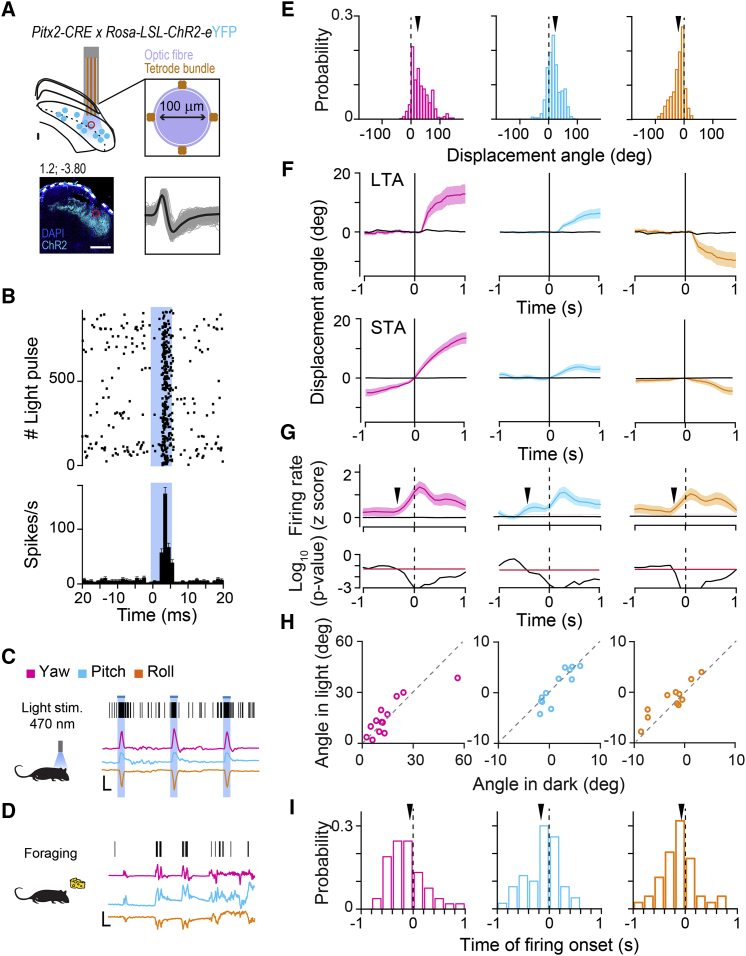
Pitx2ON Neurons Are Active Prior to Head Displacements of Fixed Metric(A) Optetrode targeted to the SGI of a Pitx2-CRE::Rosa-LSL-ChR2-eYFP mouse (top left). Optetrode design (top right): tetrode bundles (gold) around the fiber optic core (blue). Immunohistochemistry showing successful targeting of the optetrode to the SGI (bottom left, scale bar: 500 μm). Spike-sorted waveforms of a responding unit expressing ChR2 (bottom right).(B) Raster plot (top) and PSTH (bottom) for the single unit in (A) during multiple trials of blue-light stimulation (5 ms, shaded area).(C) Example of spiking activity from an optotagged unit during blue-light stimulation during open-field explorative behavior, aligned to the simultaneously recorded head displacements in yaw (magenta), pitch (blue), and roll (orange) components (scale bars: 250 ms, 20 degrees).(D) Same as in (C), for the same unit recorded during foraging behavior in the absence of blue-light stimulation.(E) Distribution of yaw, pitch, and roll head movements following the spikes of an example optotagged unit. The characteristic angle for each unit was measured as the mean of these distributions (arrowhead).(F) Light-triggered (LTA, top) and spike-triggered average (STA, bottom) of head movements in the yaw, pitch, and roll components calculated for the optotagged neuron in (E). LTA and STA were tested for significance against shuffled data (black curves).(G) Average changes in firing rate for the optotagged neuron in (F) around the onset (dashed line) of head movements, calculated separately for yaw, pitch, and roll displacements. The time of firing onset was identified by comparison against null distributions obtained from shuffled data (black arrowhead; red line indicates the significance) (bottom).(H) For each optotagged unit recorded, the characteristic yaw, pitch, and roll movement angles measured during foraging behavior in the presence of light are plotted against the angles measured during foraging in the dark (pYAW = 0.89; pPITCH = 0.30; pROLL = 0.10).(I) Distribution of firing onset across optotagged units with respect to the onset of yaw, pitch, and roll movements. The mean is marked by the arrowhead (nUNITS = 13, nMICE = 2). All results are presented as mean ± SEM.See also Figure S4.